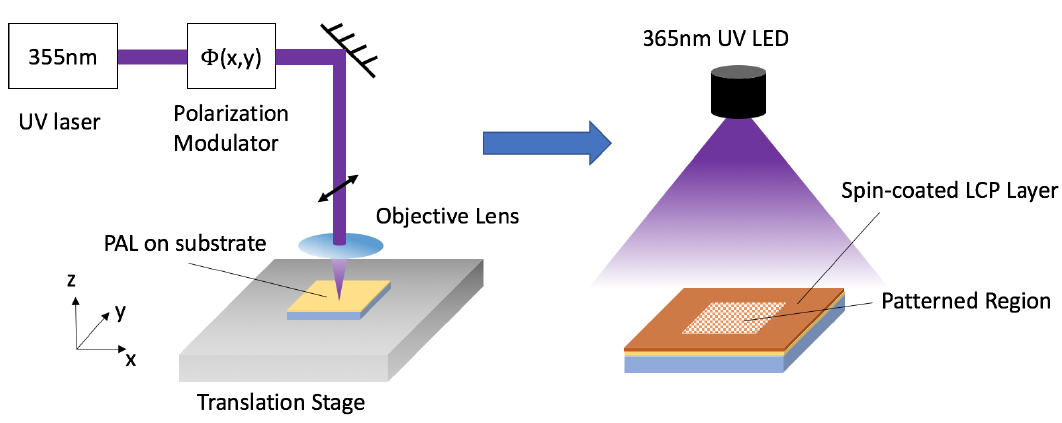
Figure 6. Illustration of the fabrication steps including UV exposure by the direct-write system and UV curing of the spin-coated